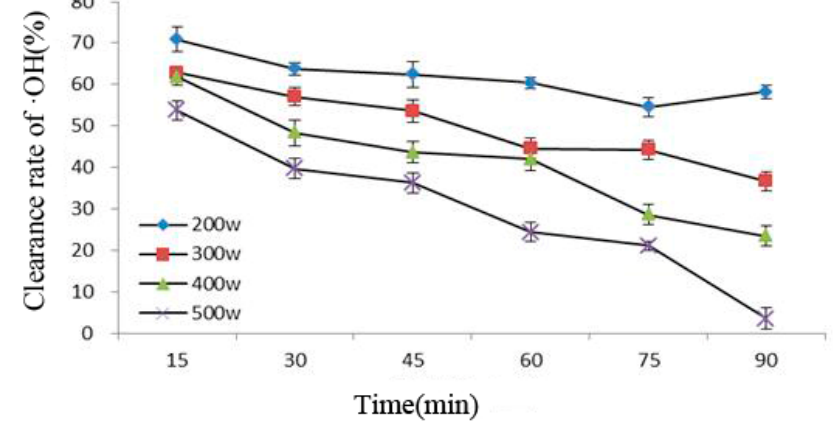
Figure 4. Correlation between clearance rate of ·OH and ultrasonic power and treatment time ( n = 3).